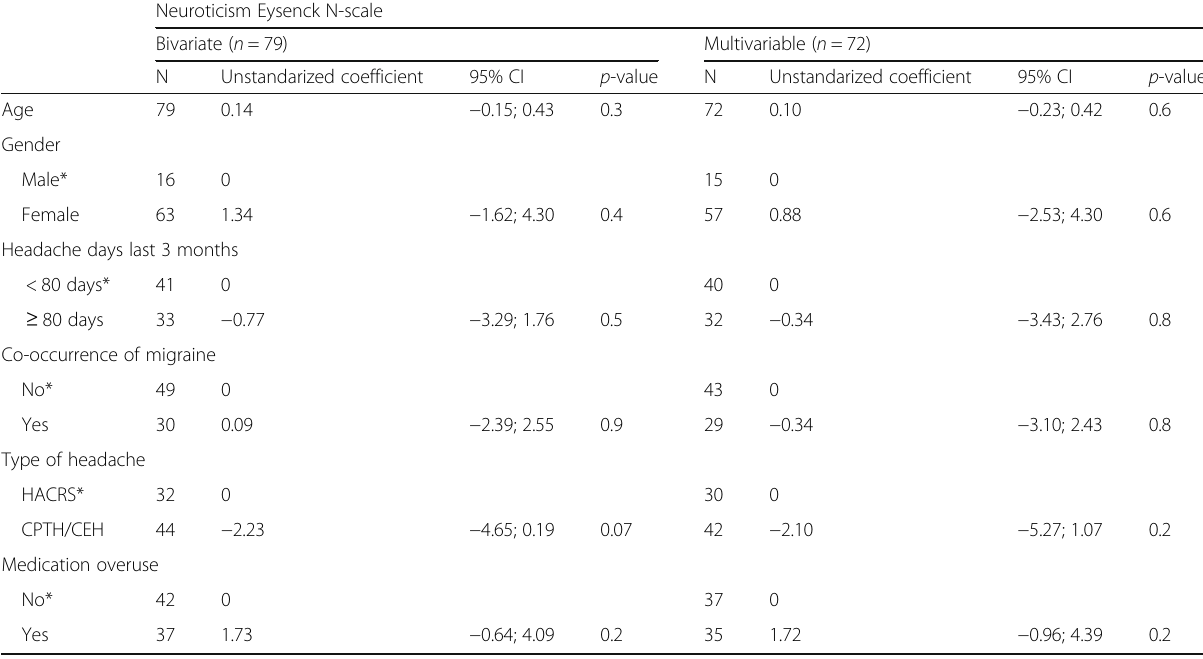
Table 3 Linear regression analysis with variables associated with neuroticism in secondary chronic headache Neuroticism Eysenck N-scale